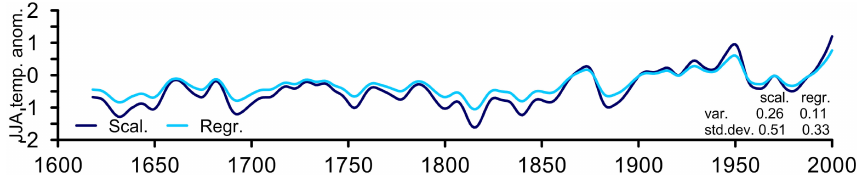
Fig. 3. Comparison of the two reconstructions obtained by scaling (Scal., dark blue line) and simple regression (Regr., light blue line). The two reconstructions were 20-yr low-pass-filtered.